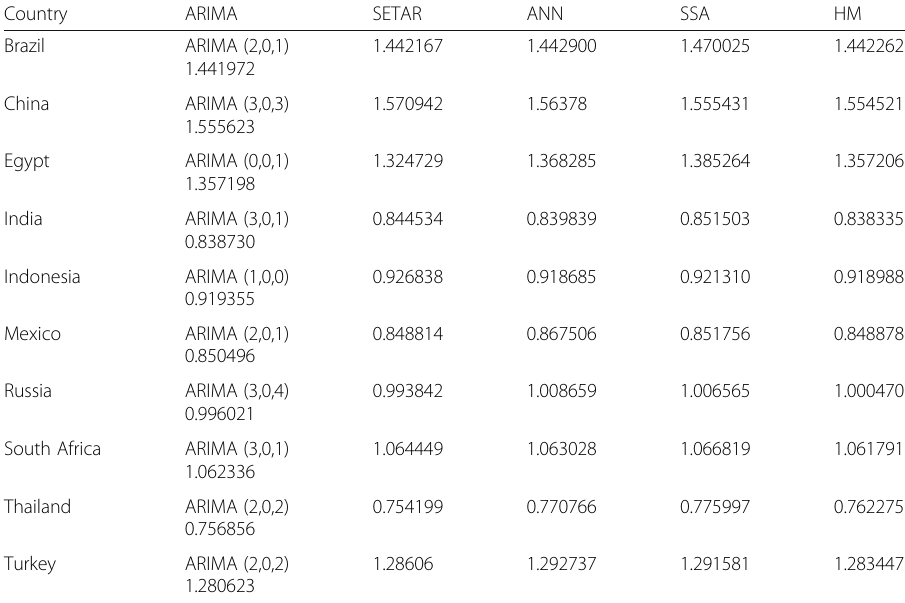
Table 5 RMSE Values of the Forecasting Models for Emerging Markets Country ARIMA SETAR ANN SSA HM Brazil